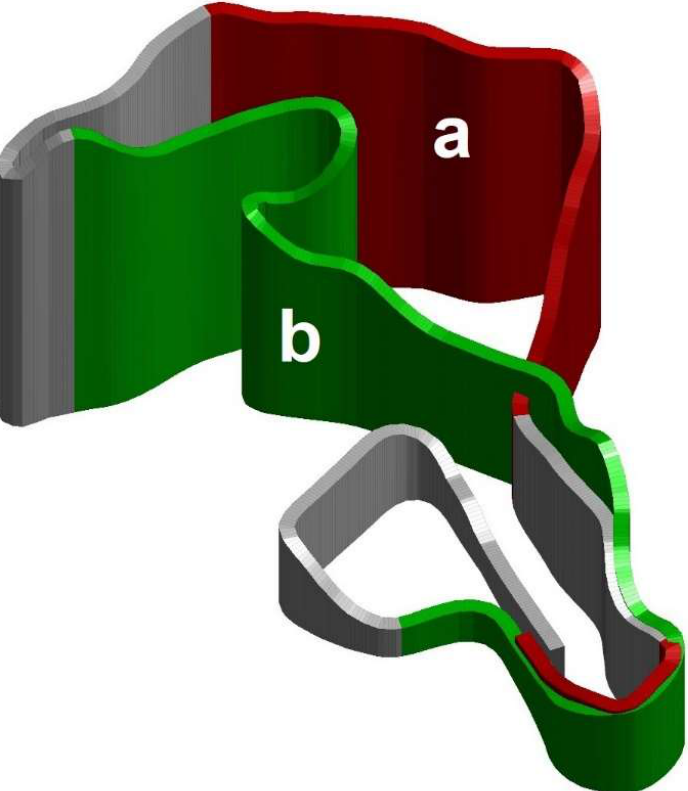
Figure 1. Tri-dimensional representation of the experimental track obtained using the global naviga- tion satellite system. Uphill is represented in red ( a ) and downhill in green ( b ). Synchronization between the two Physilog 5 IMUs was performed internally using a radio signal, and the synchronization between the IMUs, the force grips, the force insole and the OptimEye S5 device was performed manually using a dedicated pole plant and a jump at the beginning of each trial.